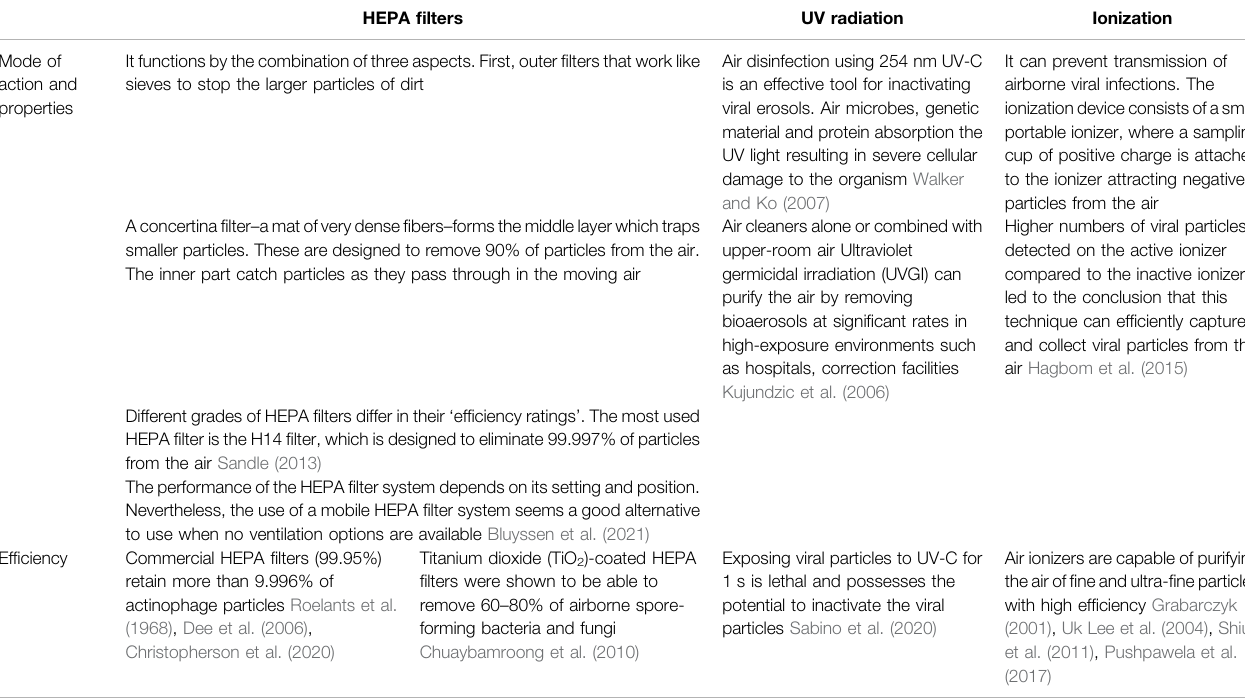
TABLE 1 | a comparison between the most common methods of air fi ltration and puri fi cation that are used to fi ght bacteria, fungi and virus spread. HEPA fi